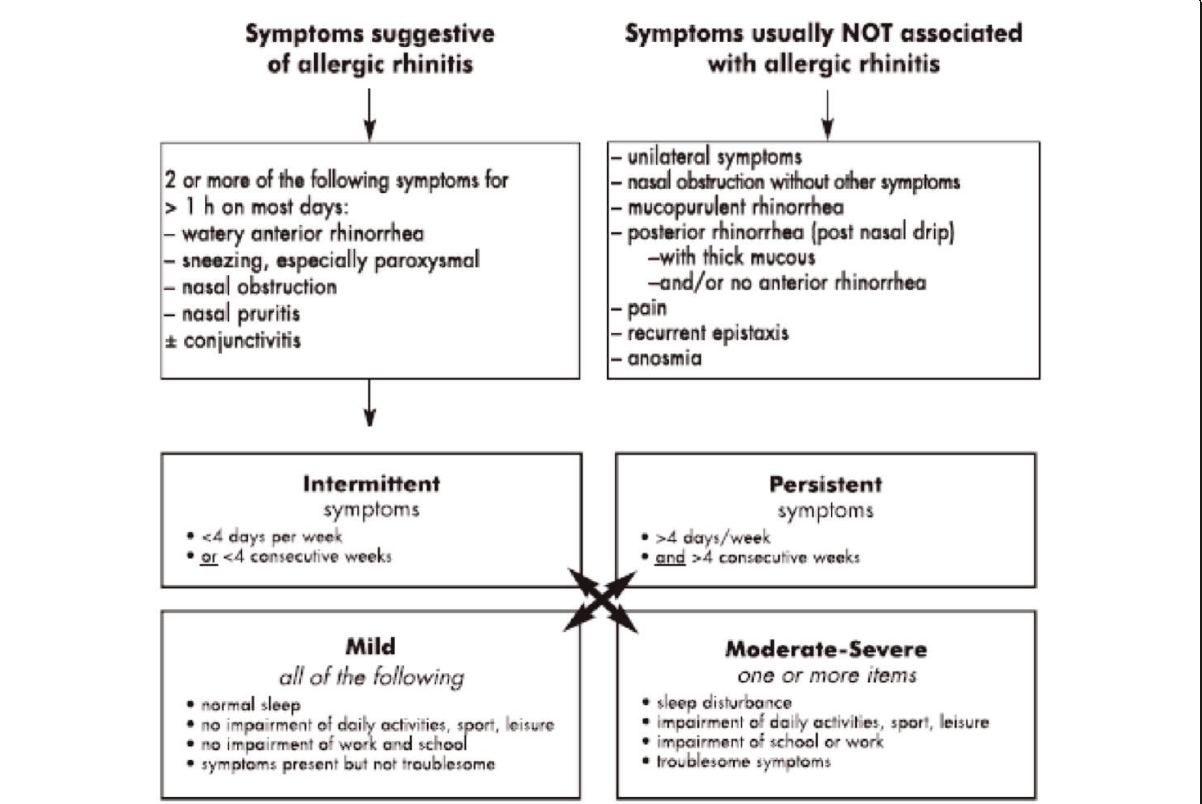
Figure 1 Symptom-based diagnosis of allergic rhinitis .